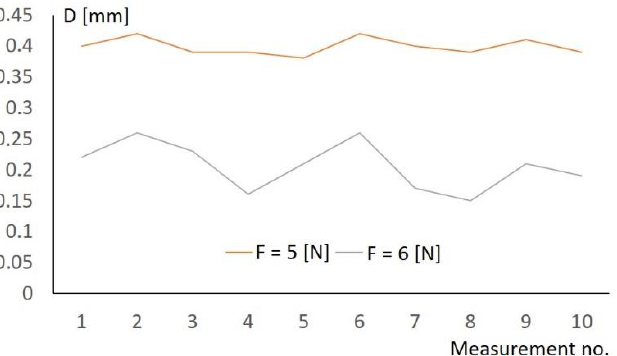
Figure 13. Examination of the stability process for different force values.